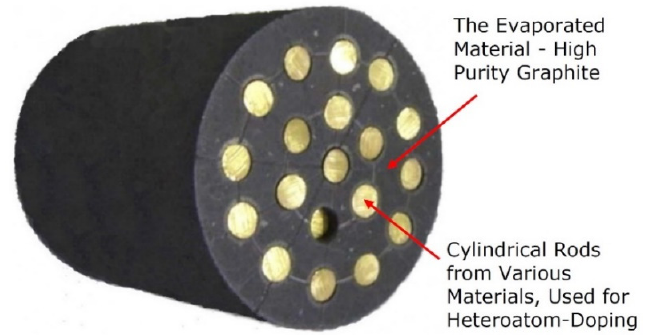
Figure 7. Example of design of a cylindrical main discharge cathode (evaporated material, the high